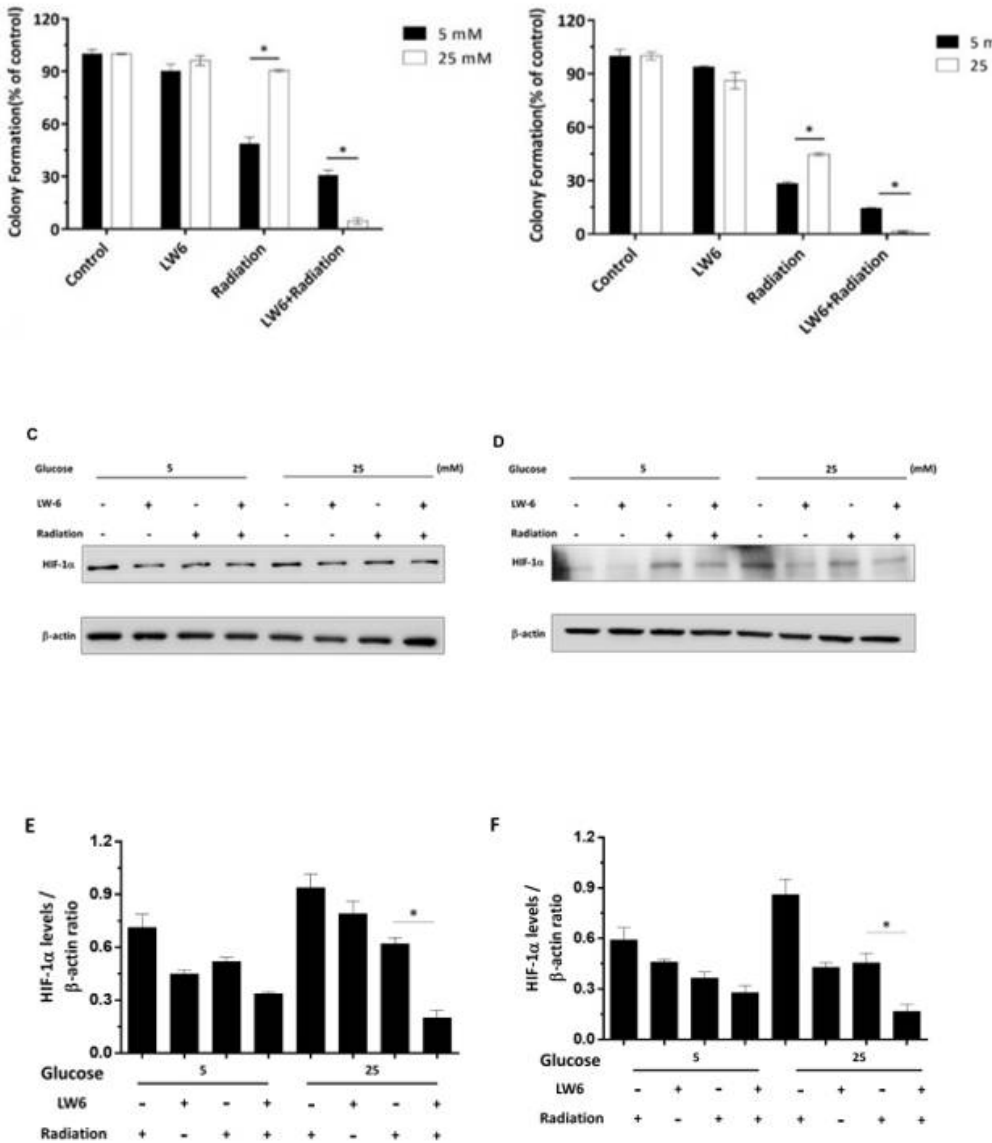
Figure 5. HIF-1α inhibitor increases the cytotoxic effect of radiation on rectal cancer cell lines in a high glucose environment. Rectal cancer cells were cultured in a high glucose concentration medium after being treated with/without radiation or LW6 for three weeks and the colony formation of HCT116 ( A ) or SW480 ( B ) is shown. The statistics of colony formation are shown ( A , B bottom). The cell plates were collected. To detect HIF-1α level and β-actin level by Western blotting (HCT116, ( C ); SW480, ( D )). The HIF-1α levels/β-actin ratio statistics in HCT116 ( E ) and SW480 ( F ), respectively. Data are presented as mean ± SD ( n = 3; * p < 0.05).